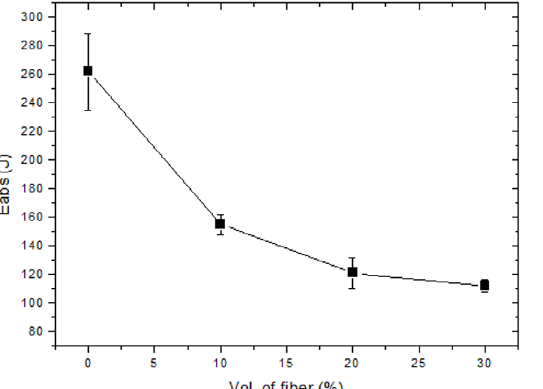
) and the Figure 4. Relation between to the energy absorbed (E abs volume fraction of fique fabric.